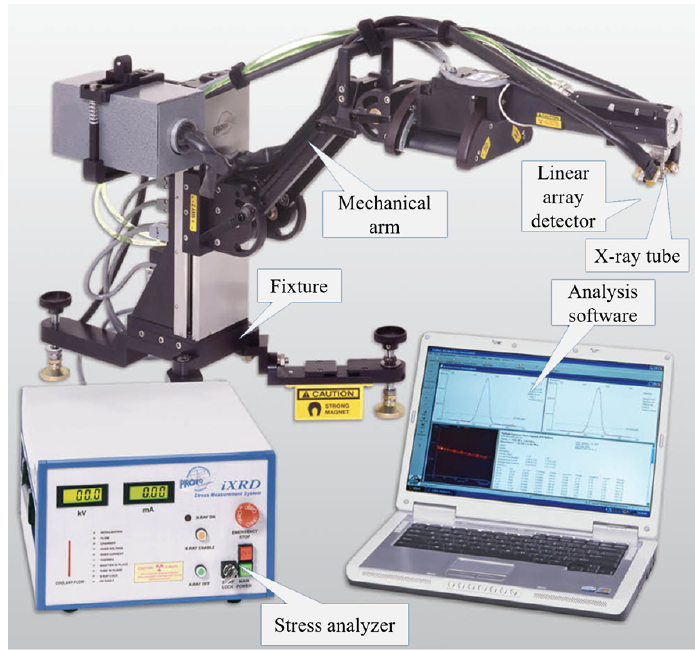
Figure 10. PROTO iXRD X ‐ ray stress measuring instrument.